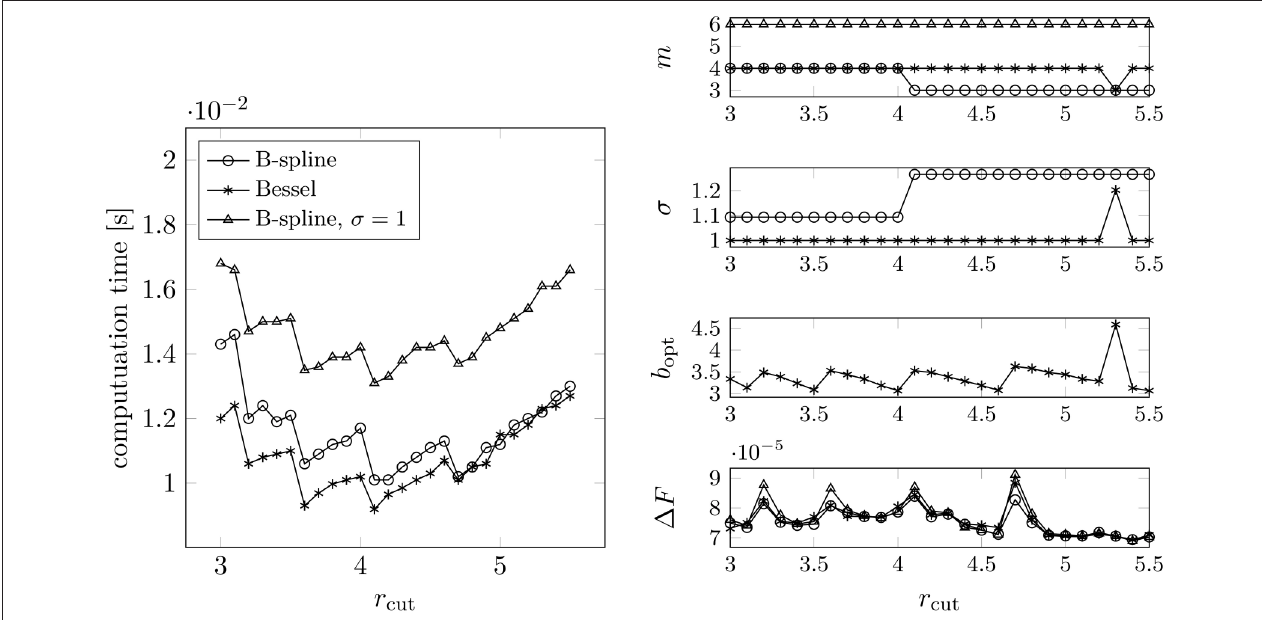
FIGURE 9 | Measured runtimes for different values of r cut (left). The required rms force accuracy was set to ε applying Algorithms 3.1, 4.1, and 4.2. For each r cut we considered different combinations of m and σ , where we chose the one yielding the smallest computation time. Test case: N 300 randomly distributed particles, box size: 10 =